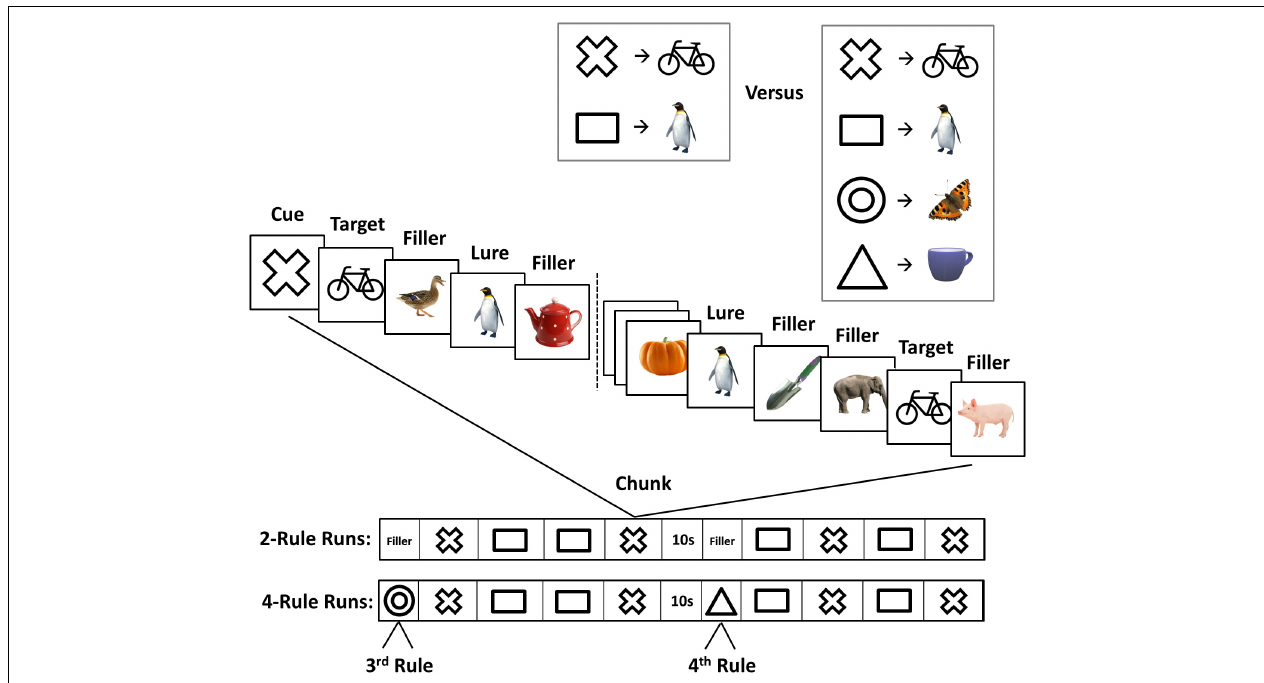
FIGURE 1 | The experimental paradigm. Top , before each experimental run, participants learned two or four novel cue-target associations (rules). Middle , in each task chunk (29 s), a cue preceded a sequence of animate and inanimate objects. The cue indicated the target in the current chunk. Other images were fillers and lures (images associated with a different cue). Bottom , sequence of task chunks in 2- and 4-rule